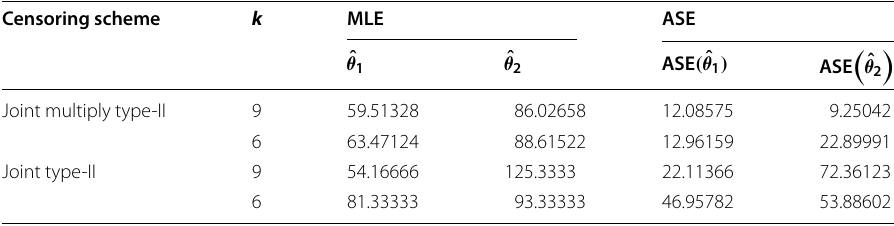
Table 4 MLE and ASE Censoring